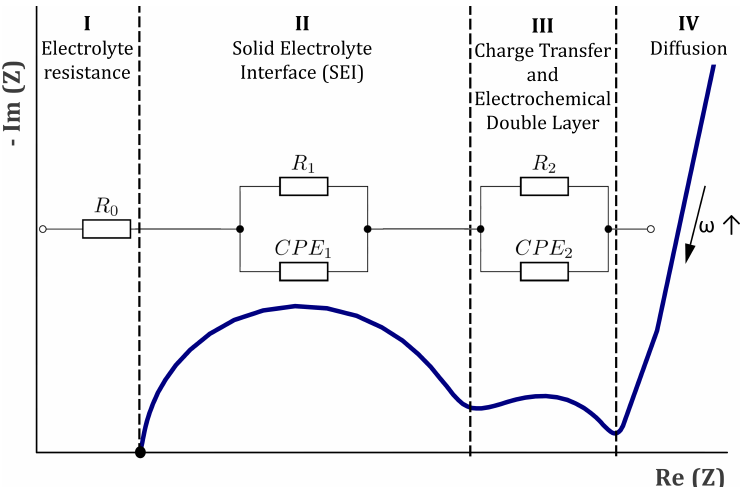
Figure 5. Schematic illustration of an impedance spectrum in a Nyquist plot and the equivalent circuit model (ECM) used in this study with its correlating impedance